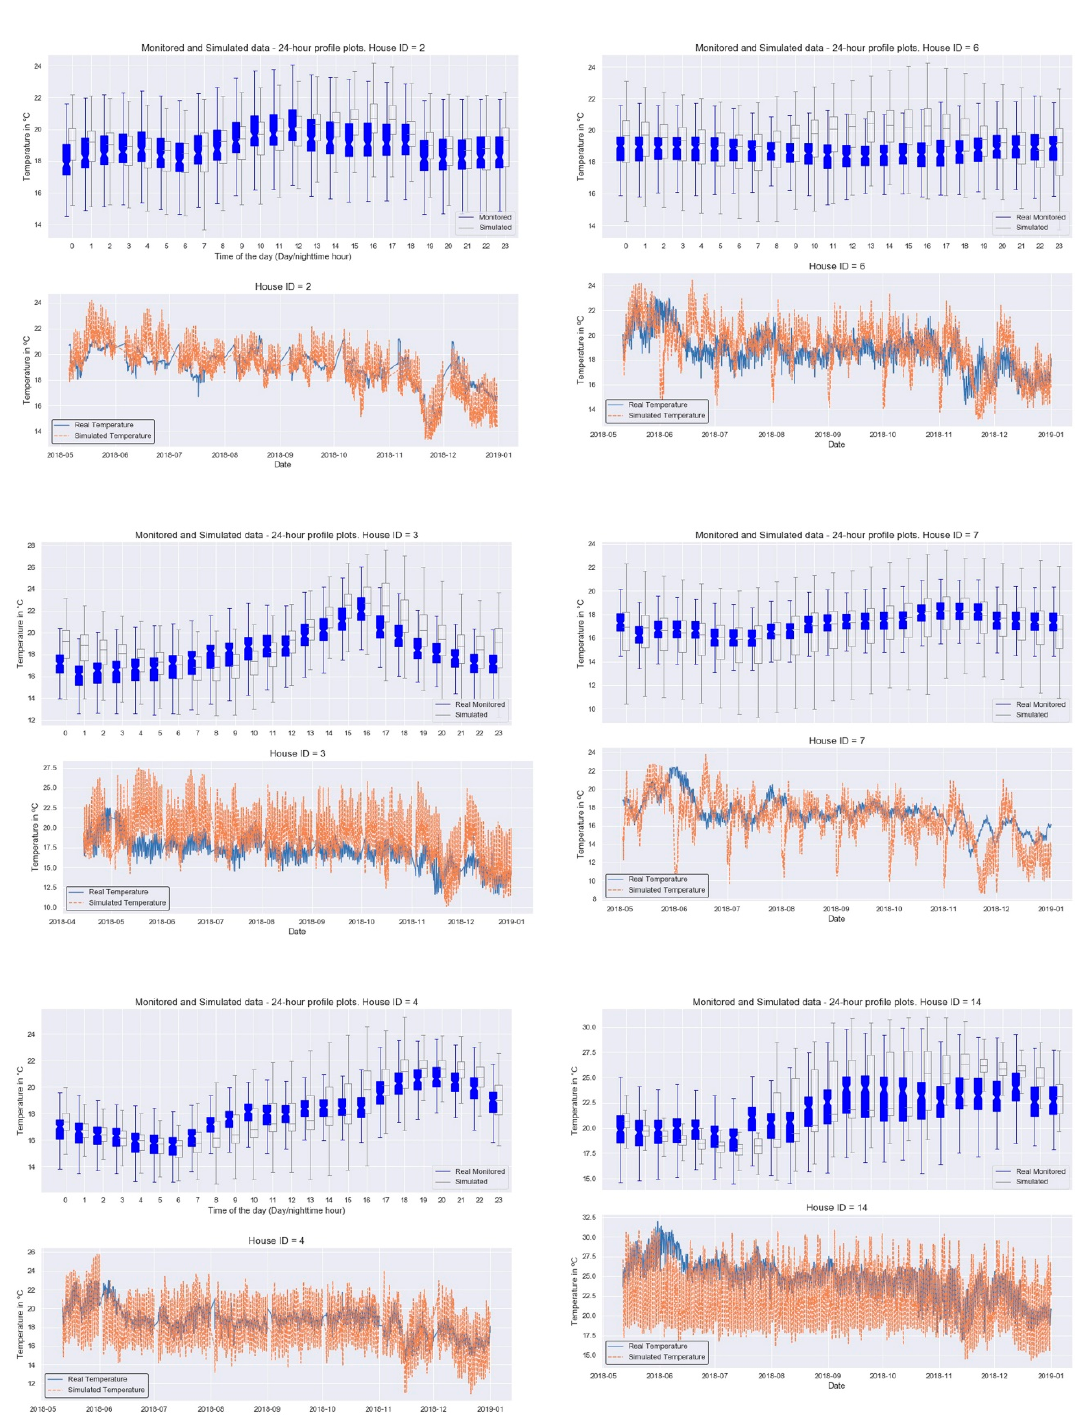
Figure A1. Results of the calibration of the models used for simulation—page 1.